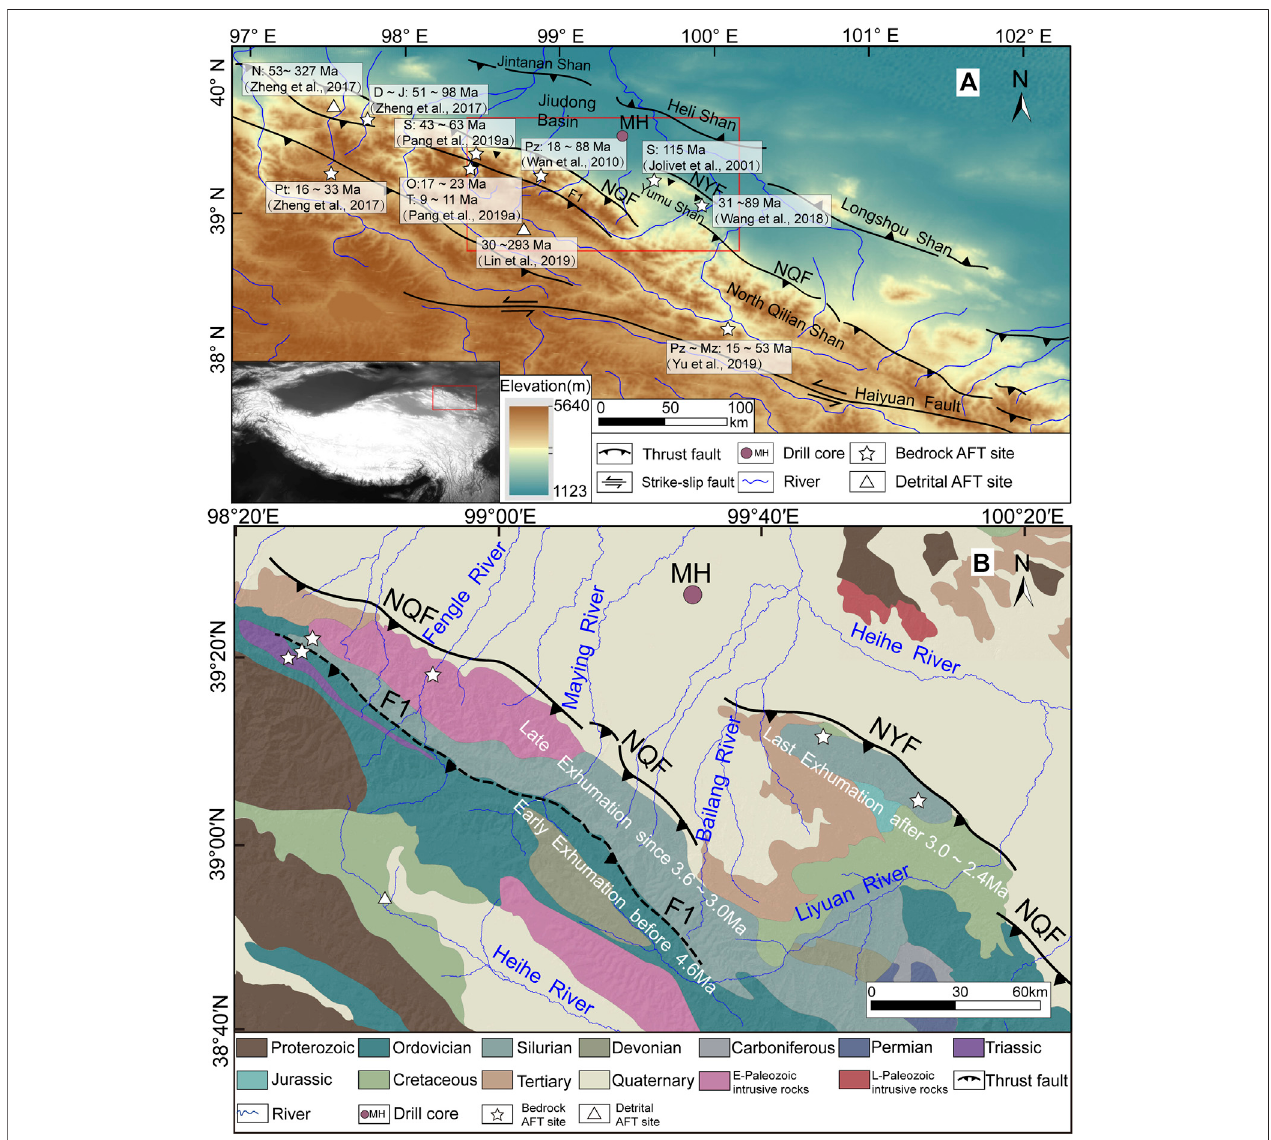
FIGURE 1 | (A) Topography of North Qilian Shan and the Hexi Corridor basin. Also shown is the distribution of major active faults, NQF — North Qilian Fault and NYF — North Yumu Shan Fault (Yuan et al., 2013), and major rivers. The numbers in the rectangles show AFT ages and the lithology unit where the sample was taken from: Pt — Proterozoic, Pz — Paleozoic, O — Ordovician, S — Silurian, D — Devonian, Mz — Mesozoic, T — Triassic, J — Jurassic, and N — Tertiary. (B) Simpli fi ed geologic map of the Jiudong Basin and the surrounding area (modi fi ed from the 1:500,000 geologic map of China).